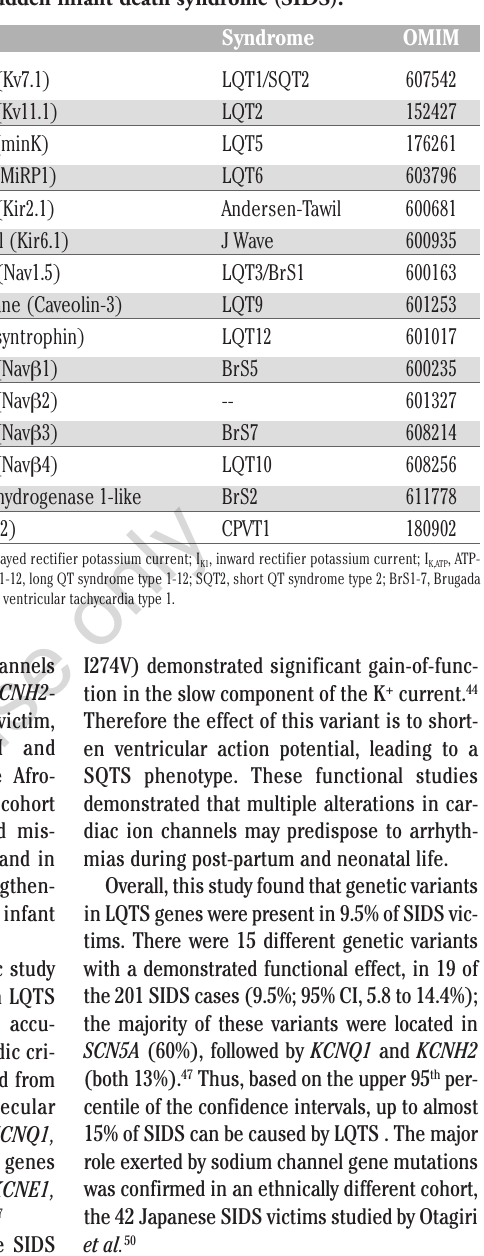
Table 2. Cardiac genes involved in sudden infant death syndrome